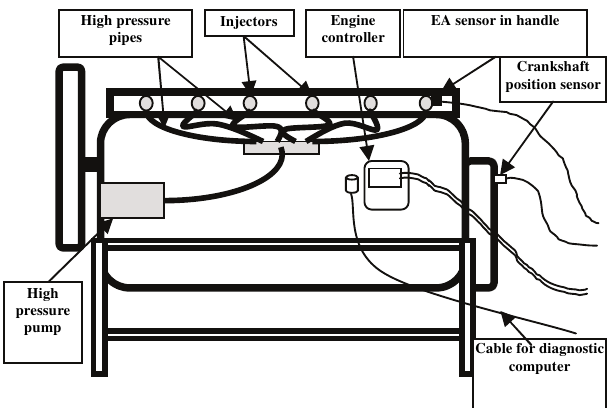
Fig. 1. A simplified diagram of the engine used for testing together with the instrumentation The basic parameters of the engine used in the tests that are certified according to EU 97/68 / EC Stage IIIA are shown in Table